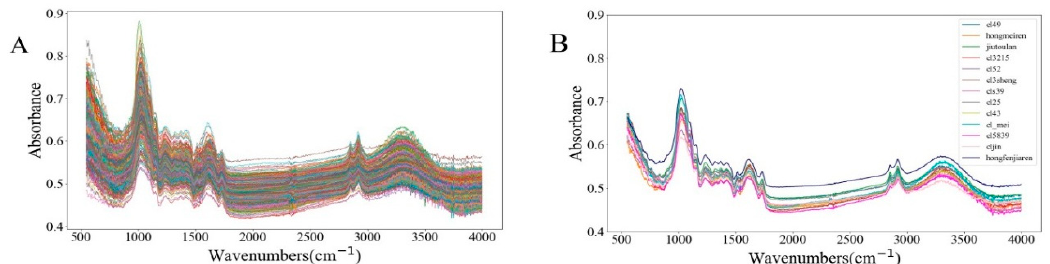
Figure 1. The profiles of ( A ) the raw spectra and ( B ) the average spectra of each orchid.